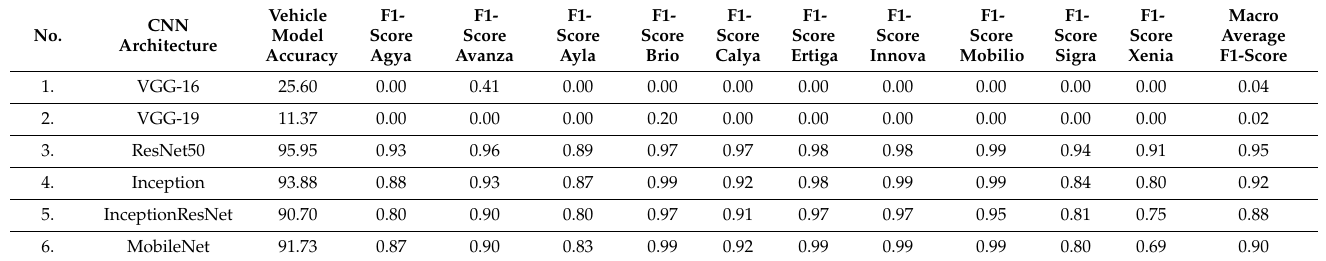
Table 4. Performance comparison for vehicle brand classification using CNN baseline